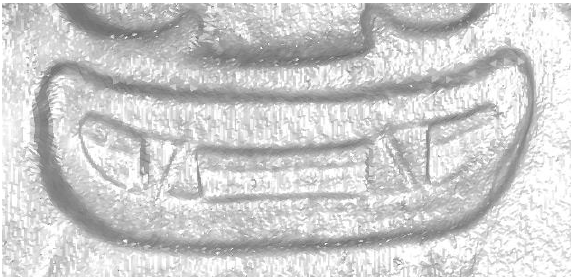
Figure 8. “Escultura 23”. Detail of Z+F mesh showing the sculpture’s mouth.